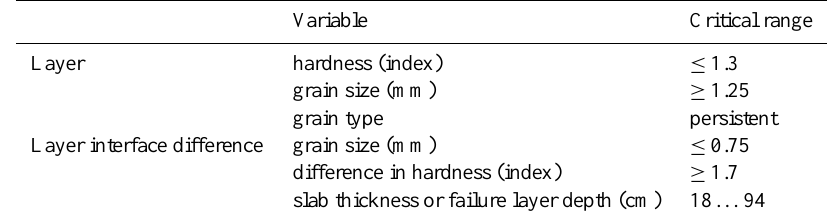
Table 1. Relevant snowpack criteria described in the threshold sum approach – TSA (Schweizer and Jamieson,